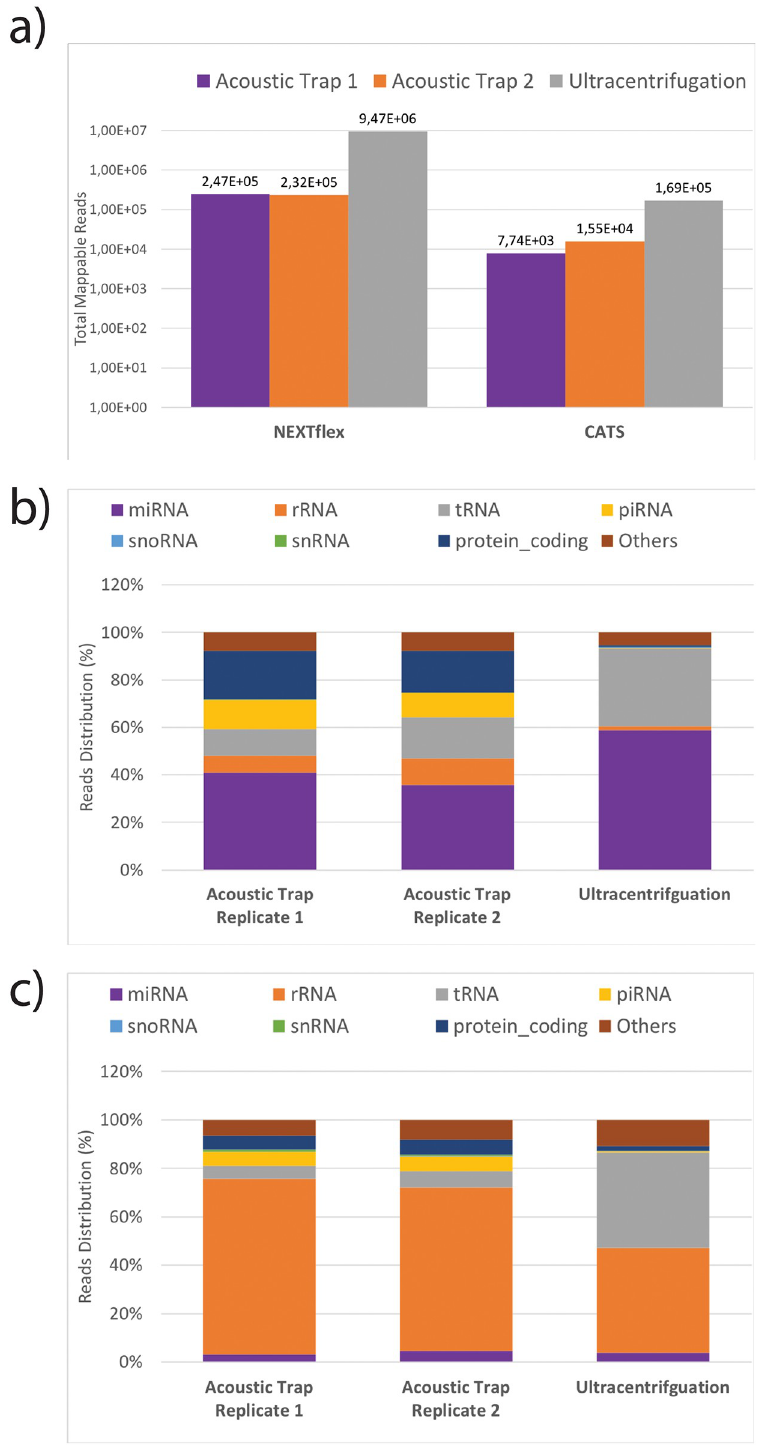
Fig 3. Comparison of NEXTFlex and CATS libraries reads and read composition. a) Total number of mappable reads obtained for NEXTFlex and CATS libraries. The NEXTFlex libraries yielded 2.5 x10 5 , 2.3 x10 5 and 9.5 x10 5 reads and the CATS libraries yielded 7.7 x10 3 , 1.6 x10 3 1.7 x10 5 reads for the two acoustic trap replicates and ultracentrifugation samples respectively. b) Mapped reads from the NEXTflex libraries showing predominantly miRNA fraction. c) Mapped reads from CATS libraries are composed of mainly rRNA.